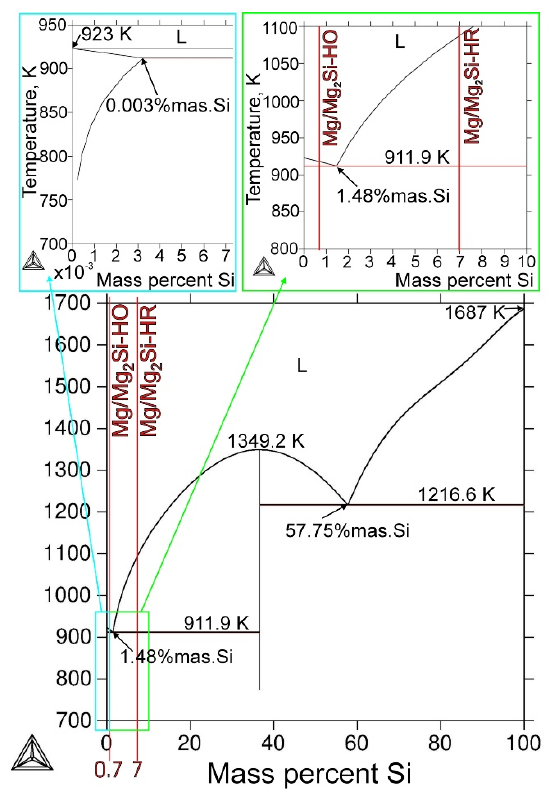
Figure 1. Mg–Si phase diagram (calculated in Thermo-Calc Software; Database: COST2 [48]).